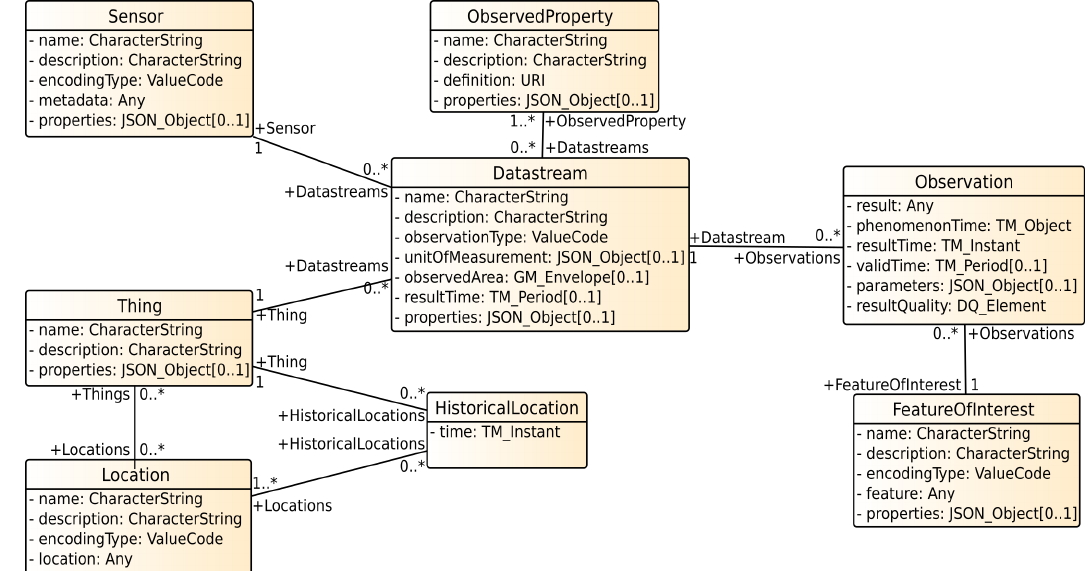
Figure 2. The SensorThings API data model